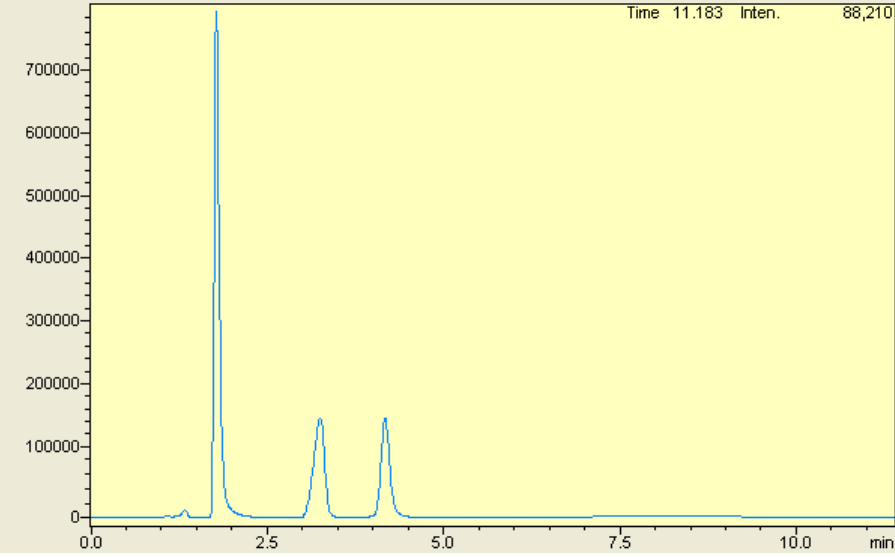
Figure 7. Chromatogram of formulation; MOX (1.76 min), VST (50 µg/mL, 3.24 min), and FLX (4.25 min).